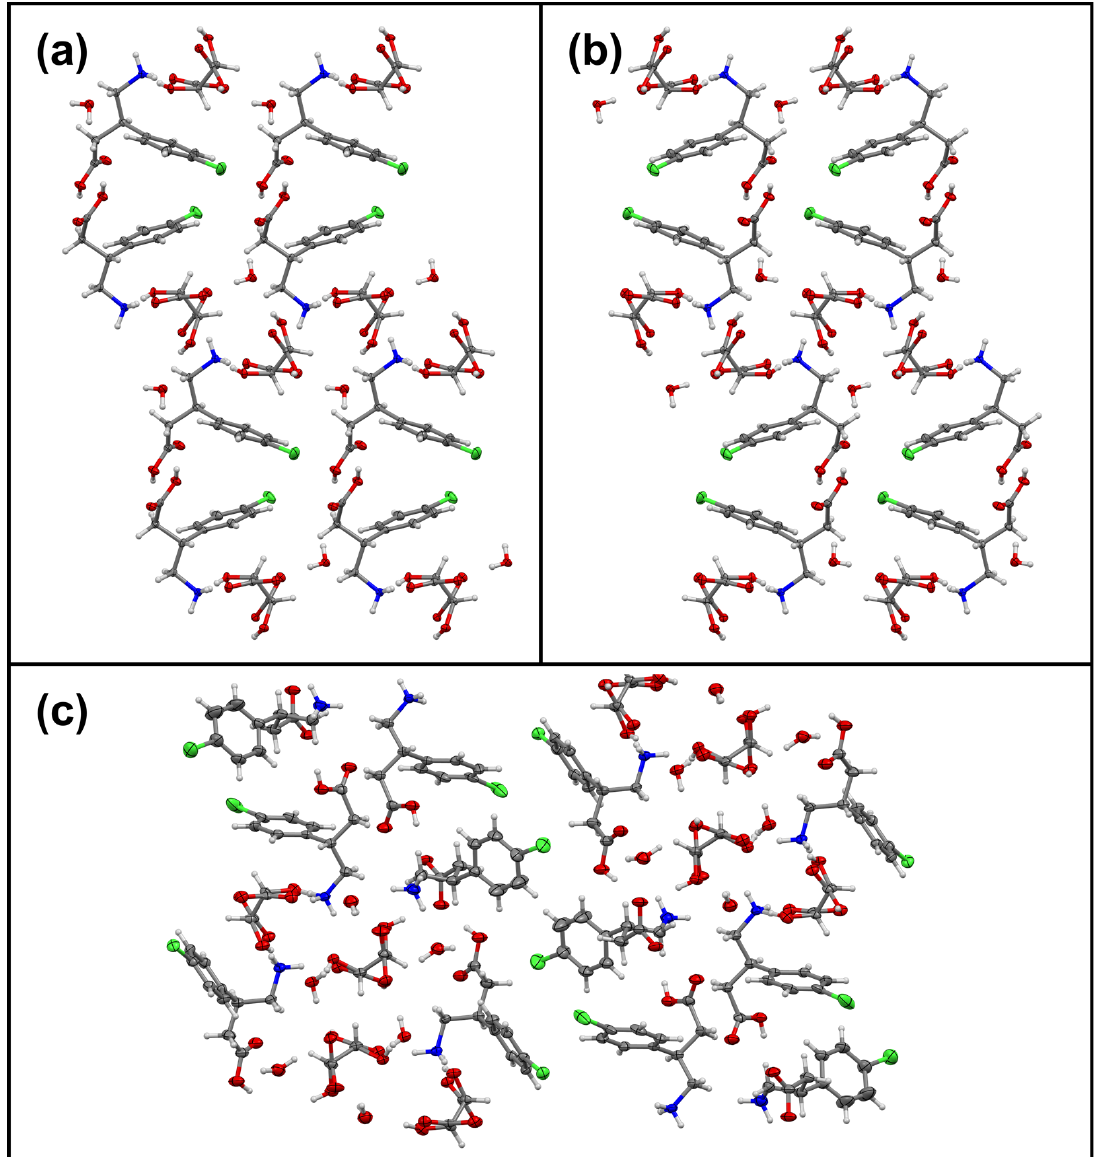
Figure 2 . Structure comparison of ( a ) Baclofen:L − tartaric acid • H 2 O (view along a-axis), ( b ) Baclofen:D − tartaric acid • H 2 O (view along a-axis) and ( c ) Baclofen:DL − tartaric acid • H 2 O (view along b-axis). While compounds (a) and ( b ) behave like mirror images and are composed of hydrate water, single-charged Baclofen and tartaric acid molecules, compound ( c ) contains additional zwitterionic Baclofen entities. Carbon atoms are depicted in grey, hydrogen atoms are white, oxygen atoms are red, nitrogen atoms are blue and chlorine atoms are green.